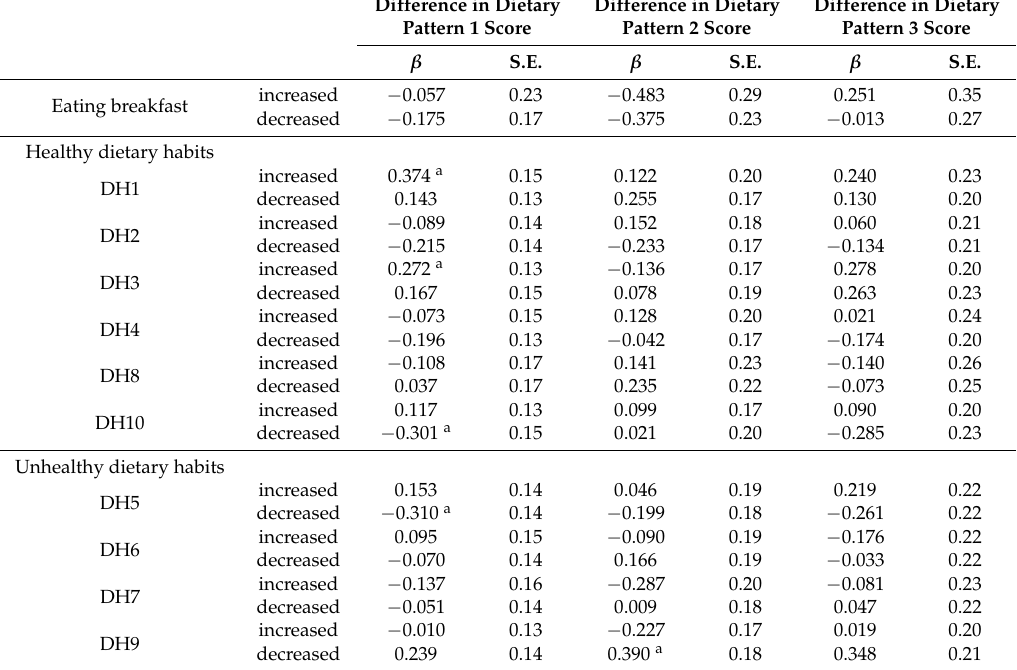
Table 5. Effects of behavioral changes over two years within dietary